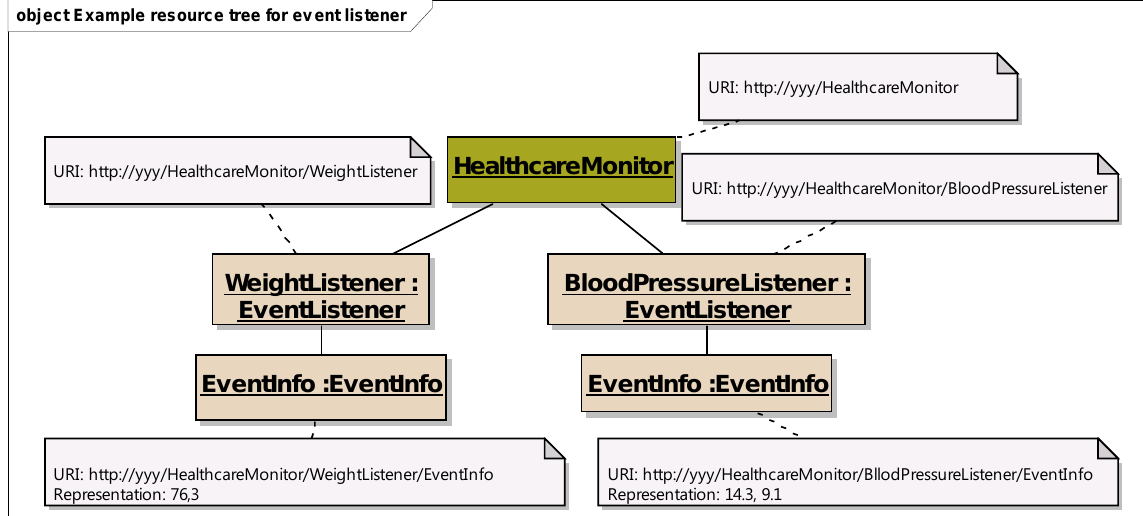
Figure 7. Resource tree for a healthcare monitor with annotations for URI and